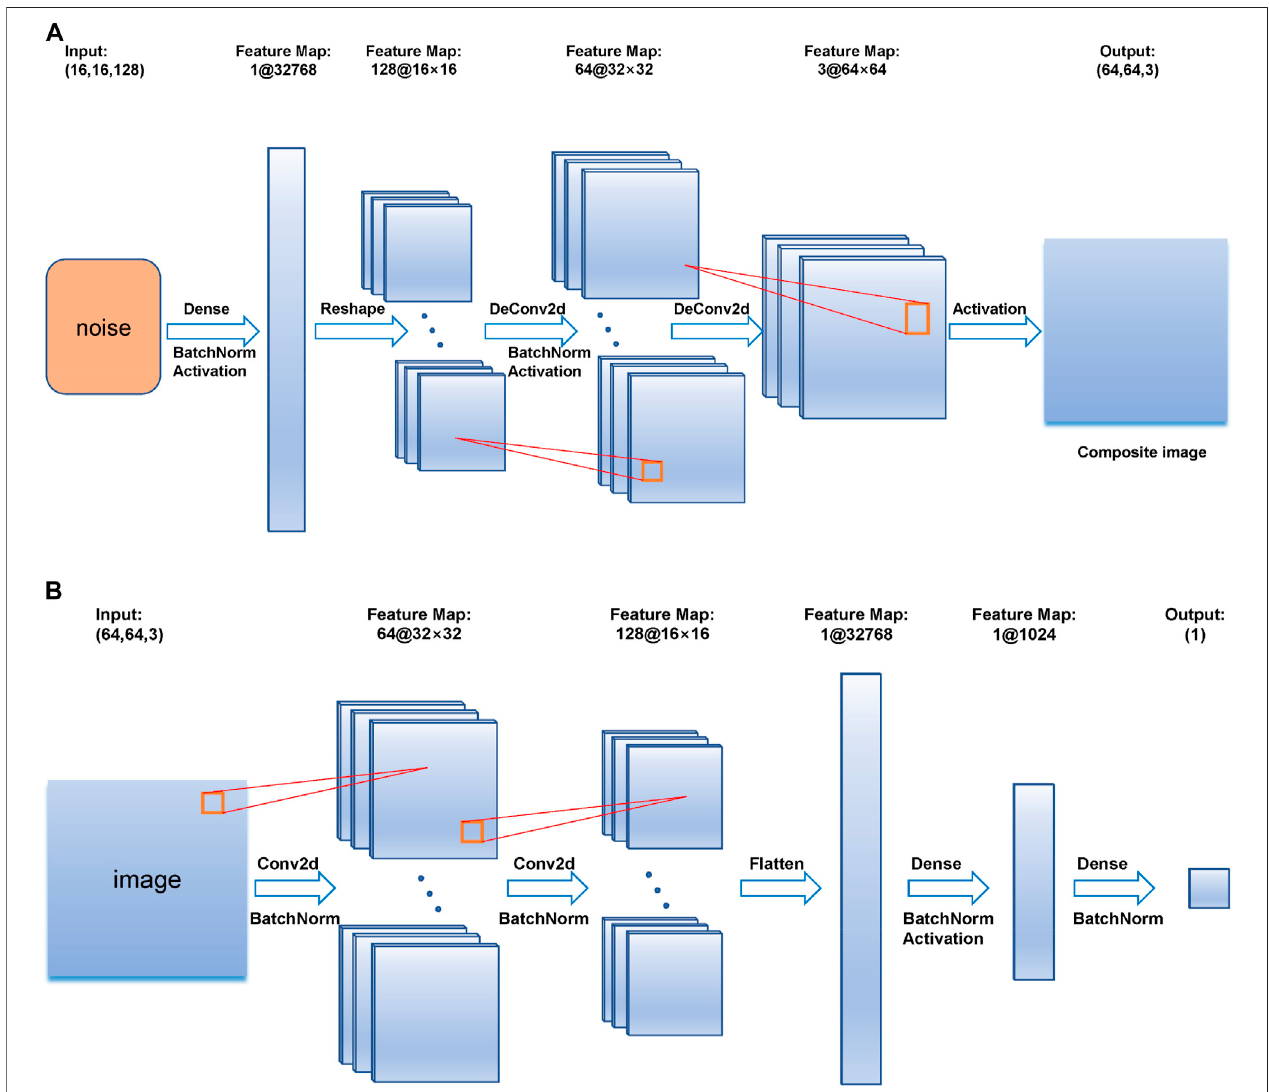
FIGURE 3 | (A) is the construction of the generator, (B) is the construction of the discriminator.